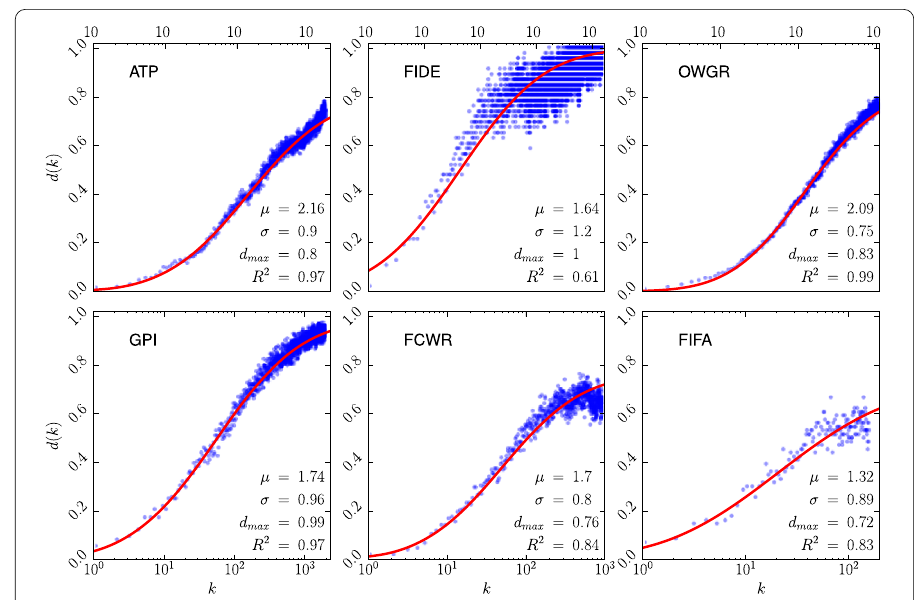
Figure 3 Rank diversity of sports and games. Plot showing the rank diversity d ( k ) for all datasets (blue dots), as well as the fit (cid:4) (red lines). We include the values of μ , σ , maximum rank diversity d max , and R 2 as